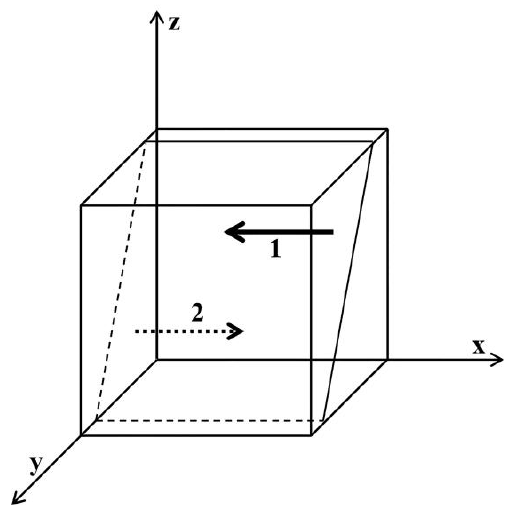
y Figure 2. Influence of on the evolutionary equilibrium stable strategy of Figure 2. Influence of y on the evolutionary equilibrium stable strategy of x . Region 1 is no regulation; regulation; region 2 is regulation. region 2 is